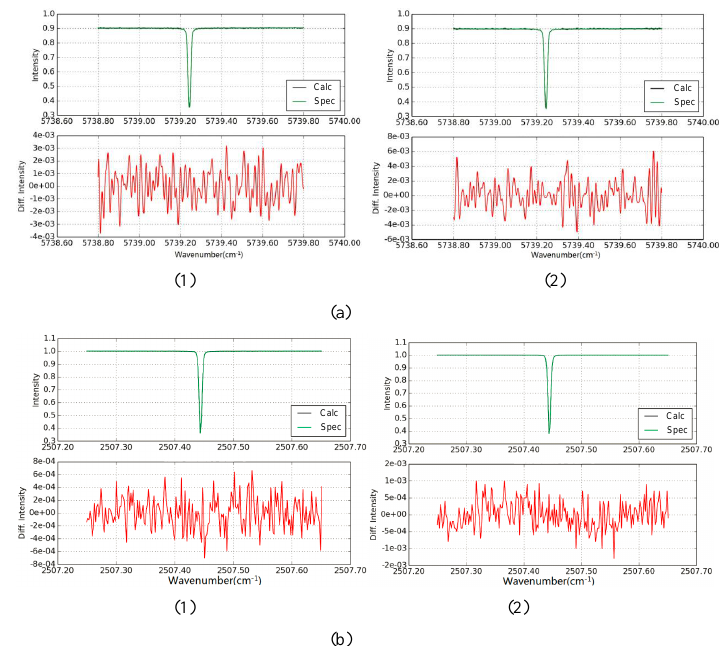
Figure 5. The LINEFIT-fitted cases for TCCON and NDACC after background removal. Panel (a1) is the TCCON ILS fitting using a lamp spectrum, (a2) is the TCCON ILS fitting using a solar spectrum, (b1) is the NDACC ILS fitting using a lamp spectrum, and (b2) is the NDACC ILS fitting using a solar spectrum. Only one micro window for each case is shown, and the residual in most cases is less than 0.2%. “calc” represents the calculated spectrum, and “spec” represents the measured